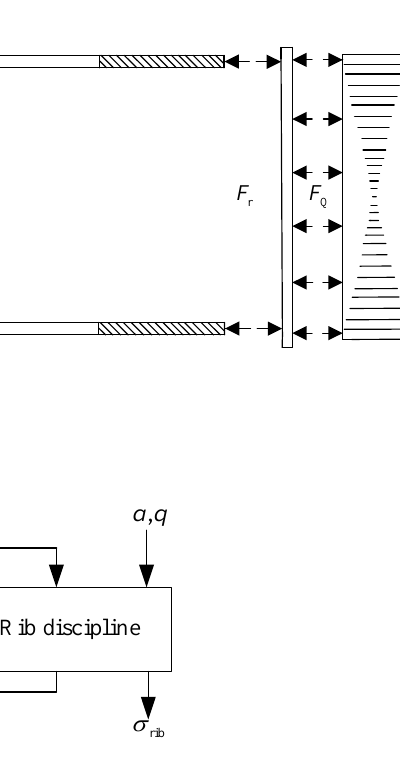
Figure 8. Disciplinary coupling relationship of the rotor mechanism.